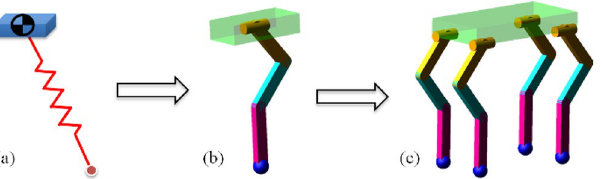
Figure 7. Extension process of the model. ( a ) 3D-SLIP equivalent model. ( b ) Multi-joint one-legged model. ( c ) Four-legged model.